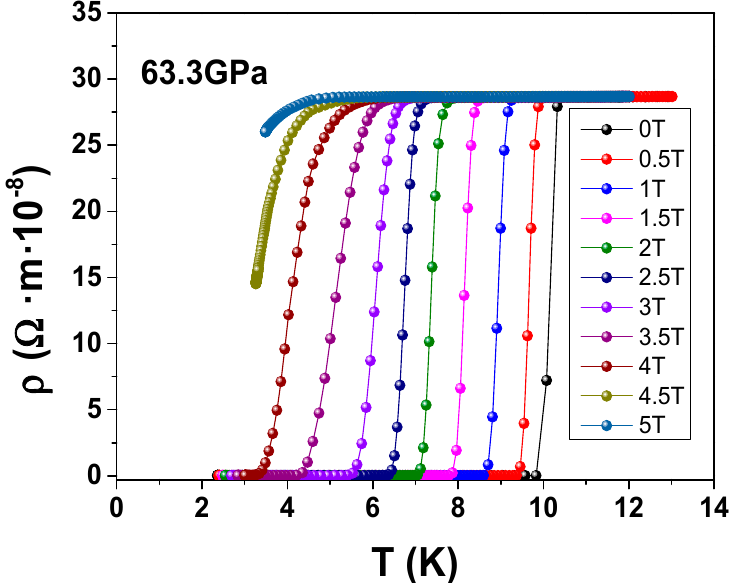
Figure 5. Temperature dependence of the resistivity at 63.3 GPa for La. The applied magnetic fields are perpendicular to the sample.